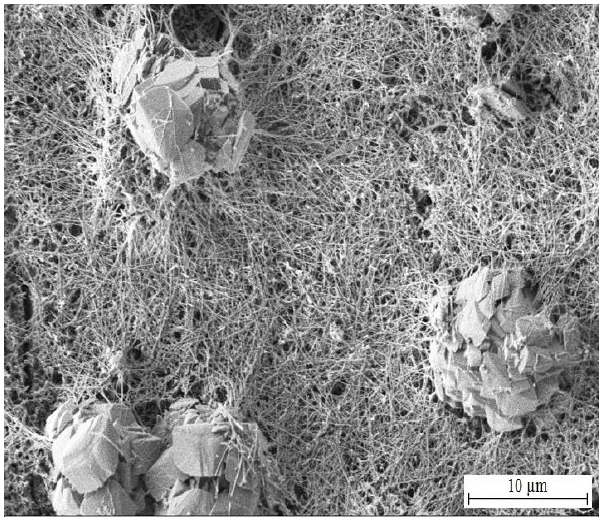
Figure 24. Detail view of precipitated corrosion products shown in Figure 23.